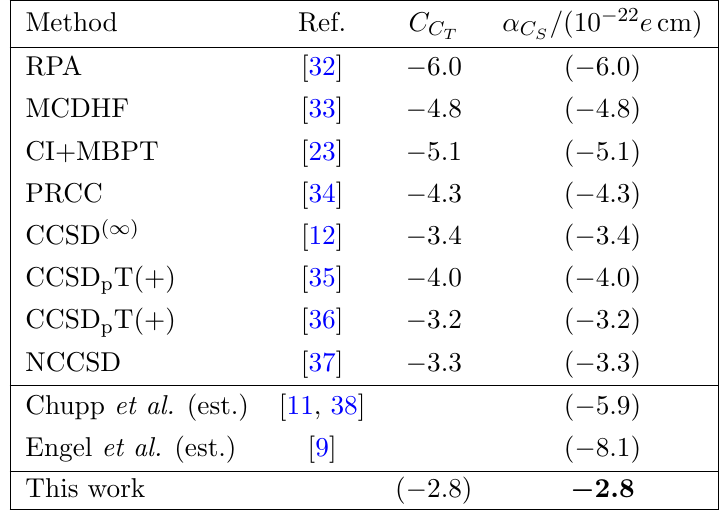
Table 2 . Comparison of the direct calculation presented here with previous calculations of (cid:11) C using calculations of (cid:11) C and the phenomenological relation eq. (3.3) (indicated by parentheses T around the result, (cid:22) Hg = 0 : 506). The literature values are ordered as to increasing sophistica- tion of the treatment of dynamic electron correlation. Numerically the conversion factor for Mer- cury reads (cid:11) Hg = 10 (cid:0) 2 (cid:11) Hg = ( h (cid:27) i (cid:1) I =I ), and a simple shell model for the nucleus is used, yielding C S C T h (cid:27) i (cid:1) I =I = (cid:0) 1 =